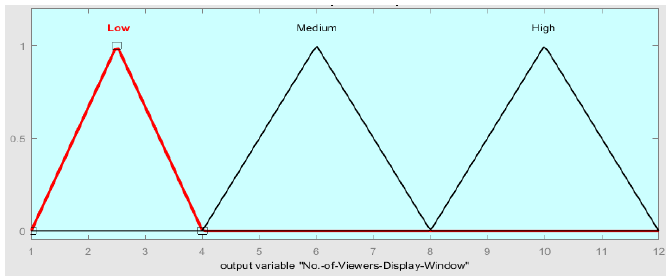
Figure 15. Output of the fuzzy model. Table 2. Membership functions of fuzzy system output.